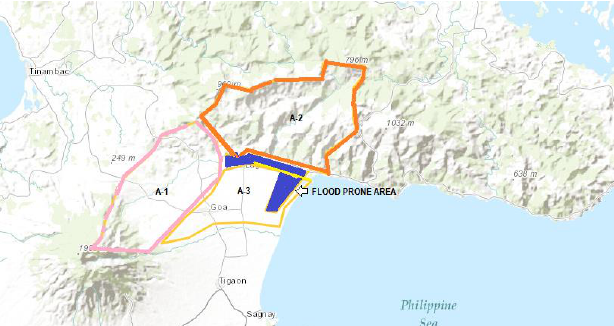
Fig. 1. The catchment and the flood prone